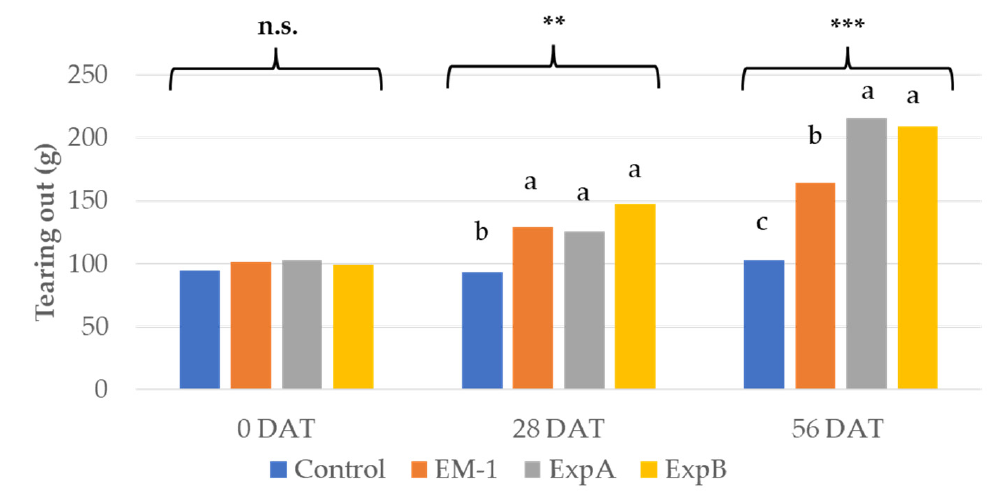
Figure 3. Tearing out resistance at 0, 28 and 56 DAT with the untreated control, EM-1, ExpA and ExpB. Different letters indicate statistically significant different means for p < 0.01 (**); p < 0.001 (***); n.s., not significant .